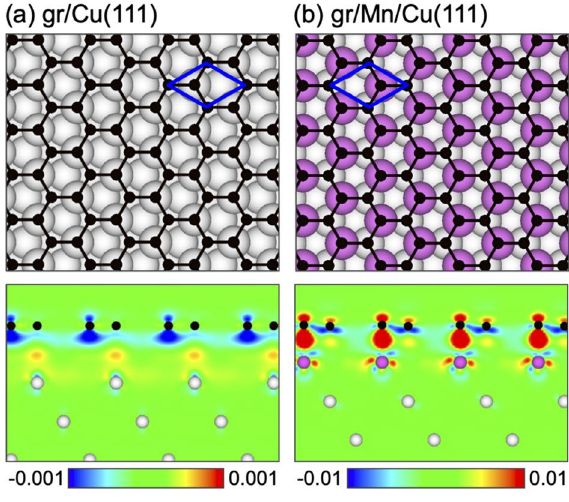
Figure 1. Top and side views of different Mn-based intercalation structures: ( a ) parent graphene/Cu(111), ( b ) graphene/Mn/Cu(111), ( c ) graphene/ Cu 2 Mn/Cu(111)–model A, and ( d ) graphene/ Cu 2 Mn/Cu(111)— model B. Spheres of different size and colour represent atoms of different types. Side views for all structures are taken along the graphene arm-chair edge and they are overlaid with electron charge difference maps �ρ( r ) ρ gr / s ( r ) ρ gr ( r ) ρ s ( r ) (gr: graphene; s: substrate). �ρ is colour coded as blue ( = − − 0.01 e / Å 3 ), green (0), and red ( 0.01 e / Å 3 ), for ( a , c , d ) and ( b ), (0), and red ( 0.001 e / Å 3 ) and blue ( −